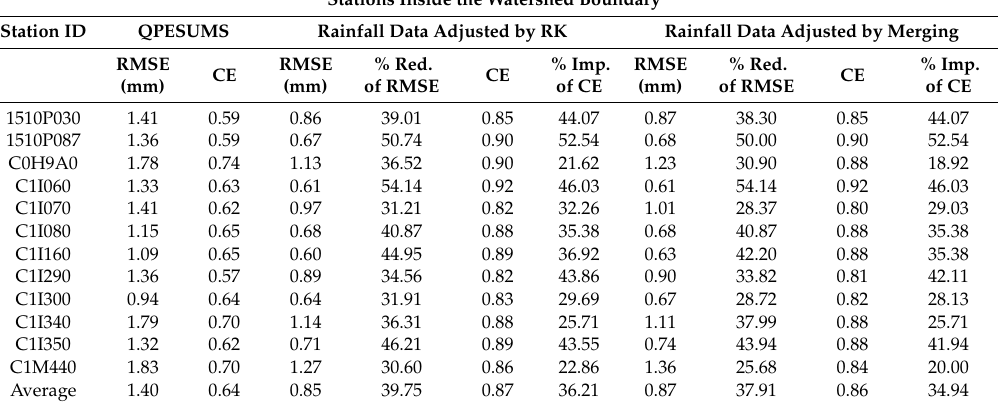
Table 5. RMSE and CE for the unadjusted QPESUMS data and adjusted radar rainfall values using RK and merging for stations inside the watershed boundary during the event of Typhoon Morakot. The values of the percentage reduction (% Red.) in the RMSE and percentage improvement (% Imp.) in CE are also included.